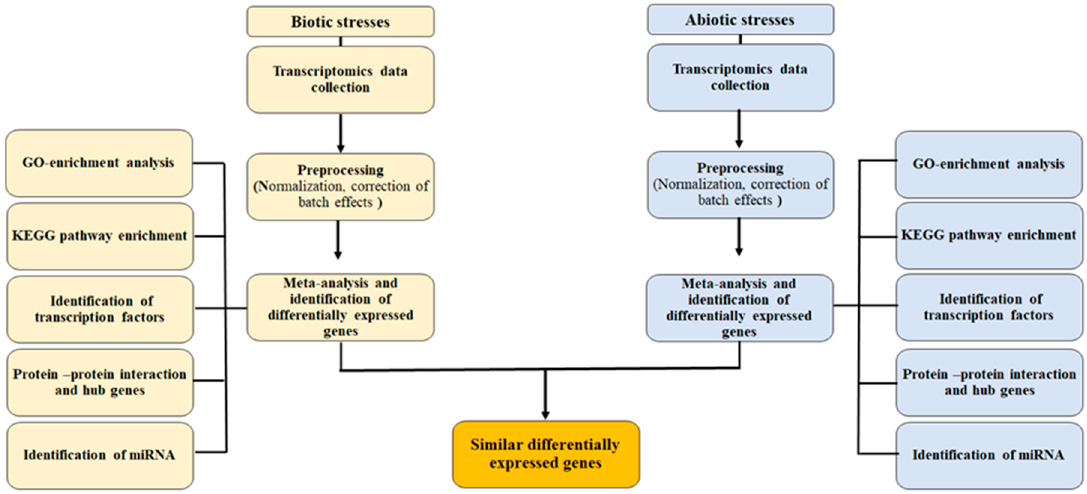
Figure 4. Meta-Analysis of an Expression Dataset.